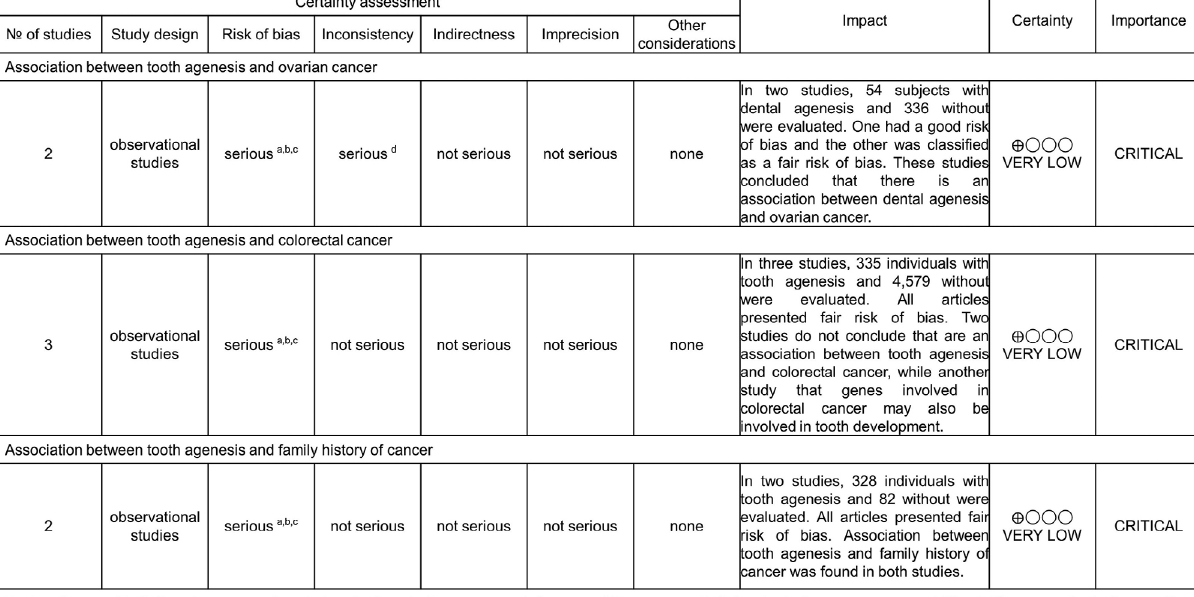
Figure 4- Grade evidence profile